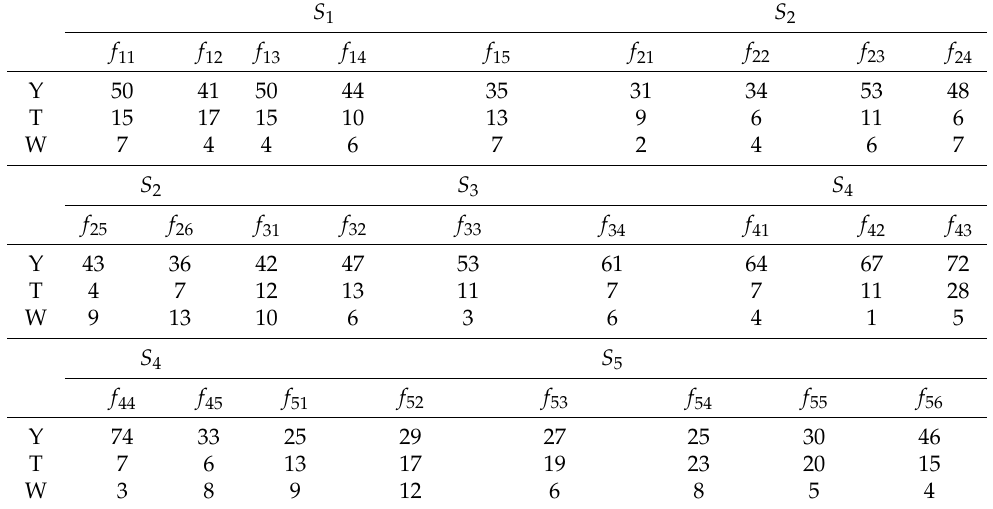
Table 1. The basic information of the optional C3DPS.